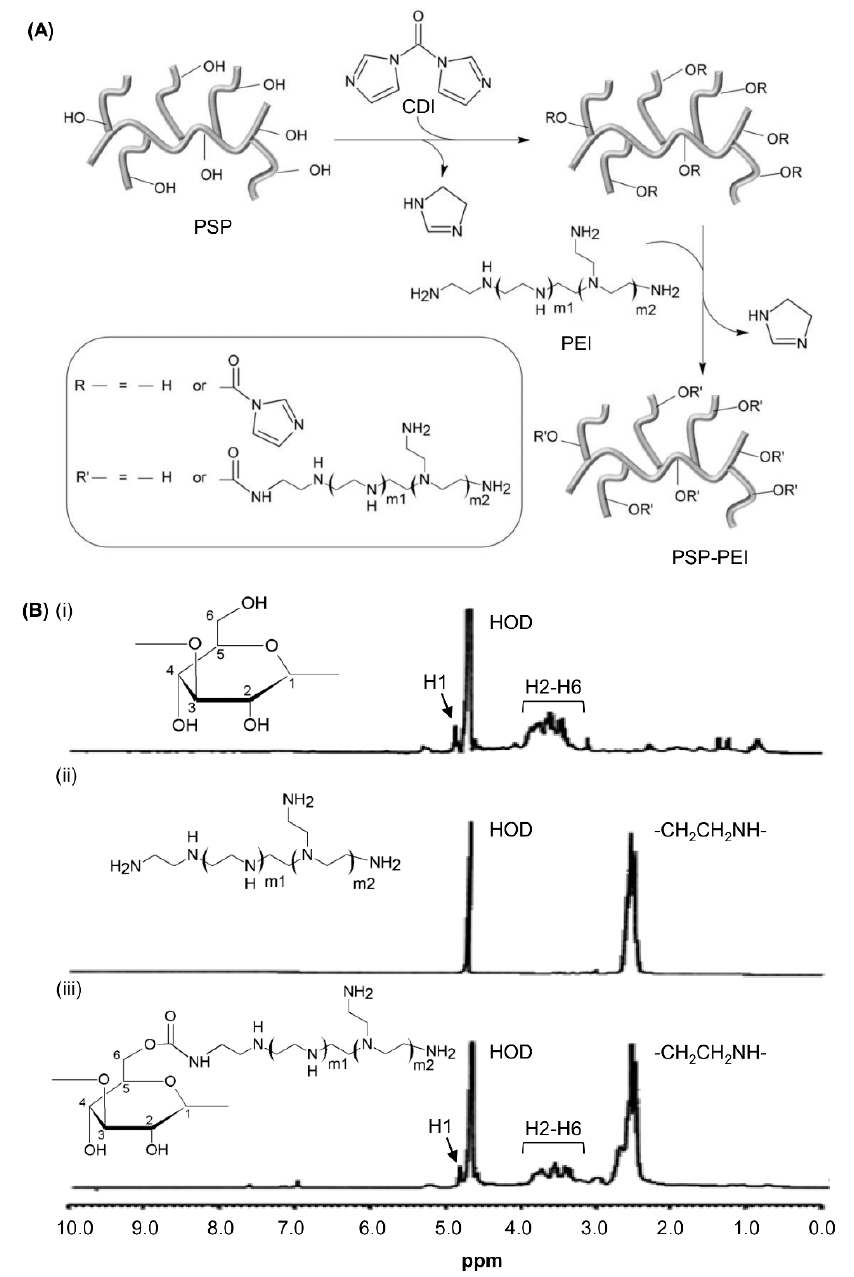
Figure 1. ( A ) Schematic diagram showing the steps involved in the synthesis of PSP-PEI. ( B ) 1 H-NMR spectra of (i) PSP, (ii) PEI, and (iii) PSP-PEI in D 2 O.